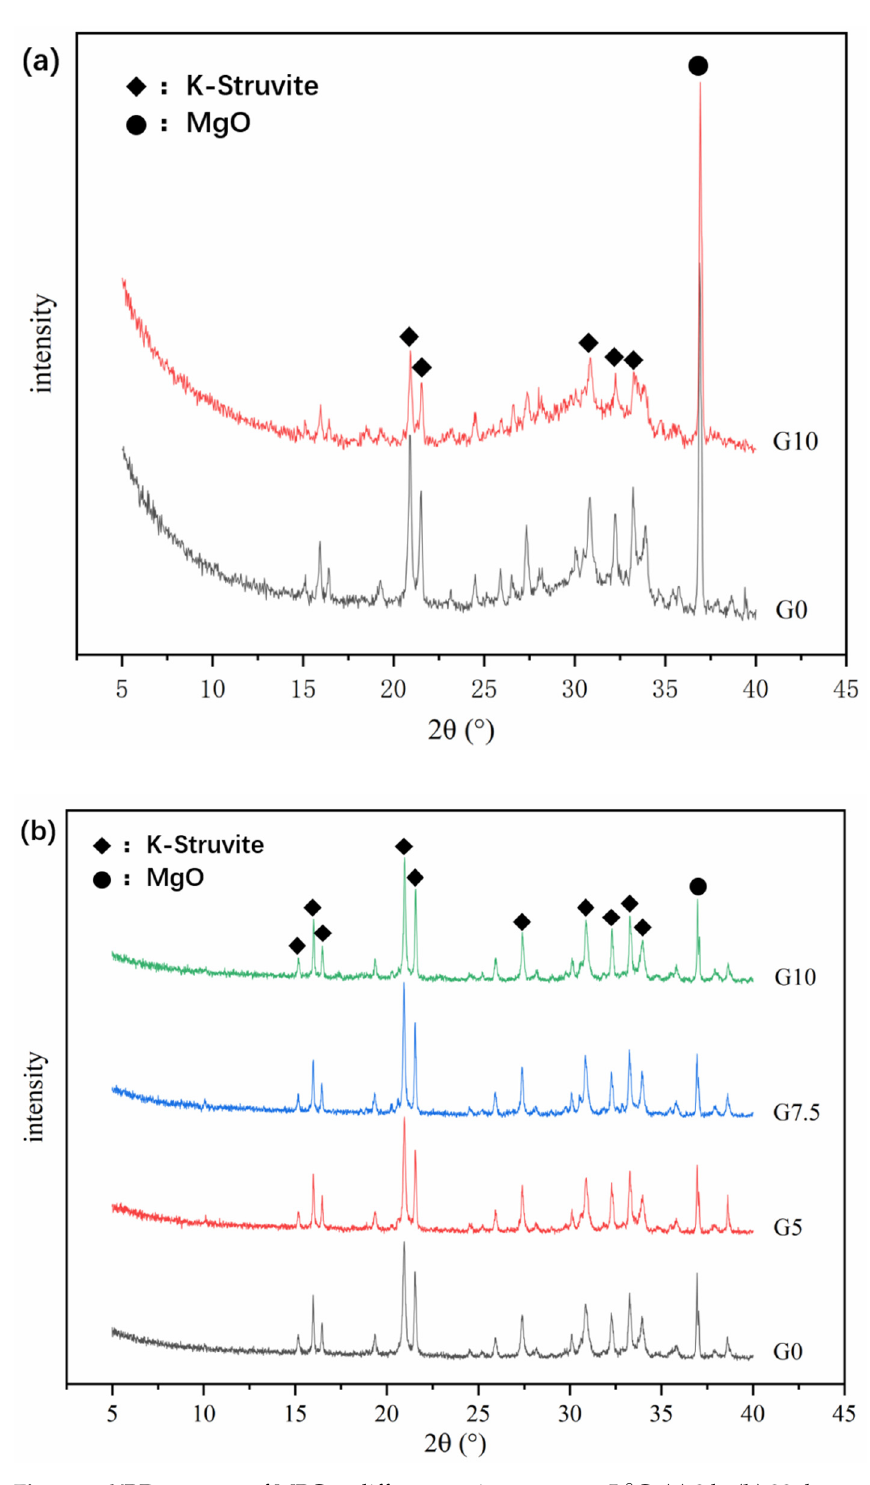
Figure 8. XRD patterns of MPC at different curing ages at − 5 ◦ C: ( a ) 3 h; ( b ) 28 Figure 8. XRD pa tt erns of MPC at di ff erent curing ages at − 5 °C: ( a ) 3 h; ( b ) 28 d.